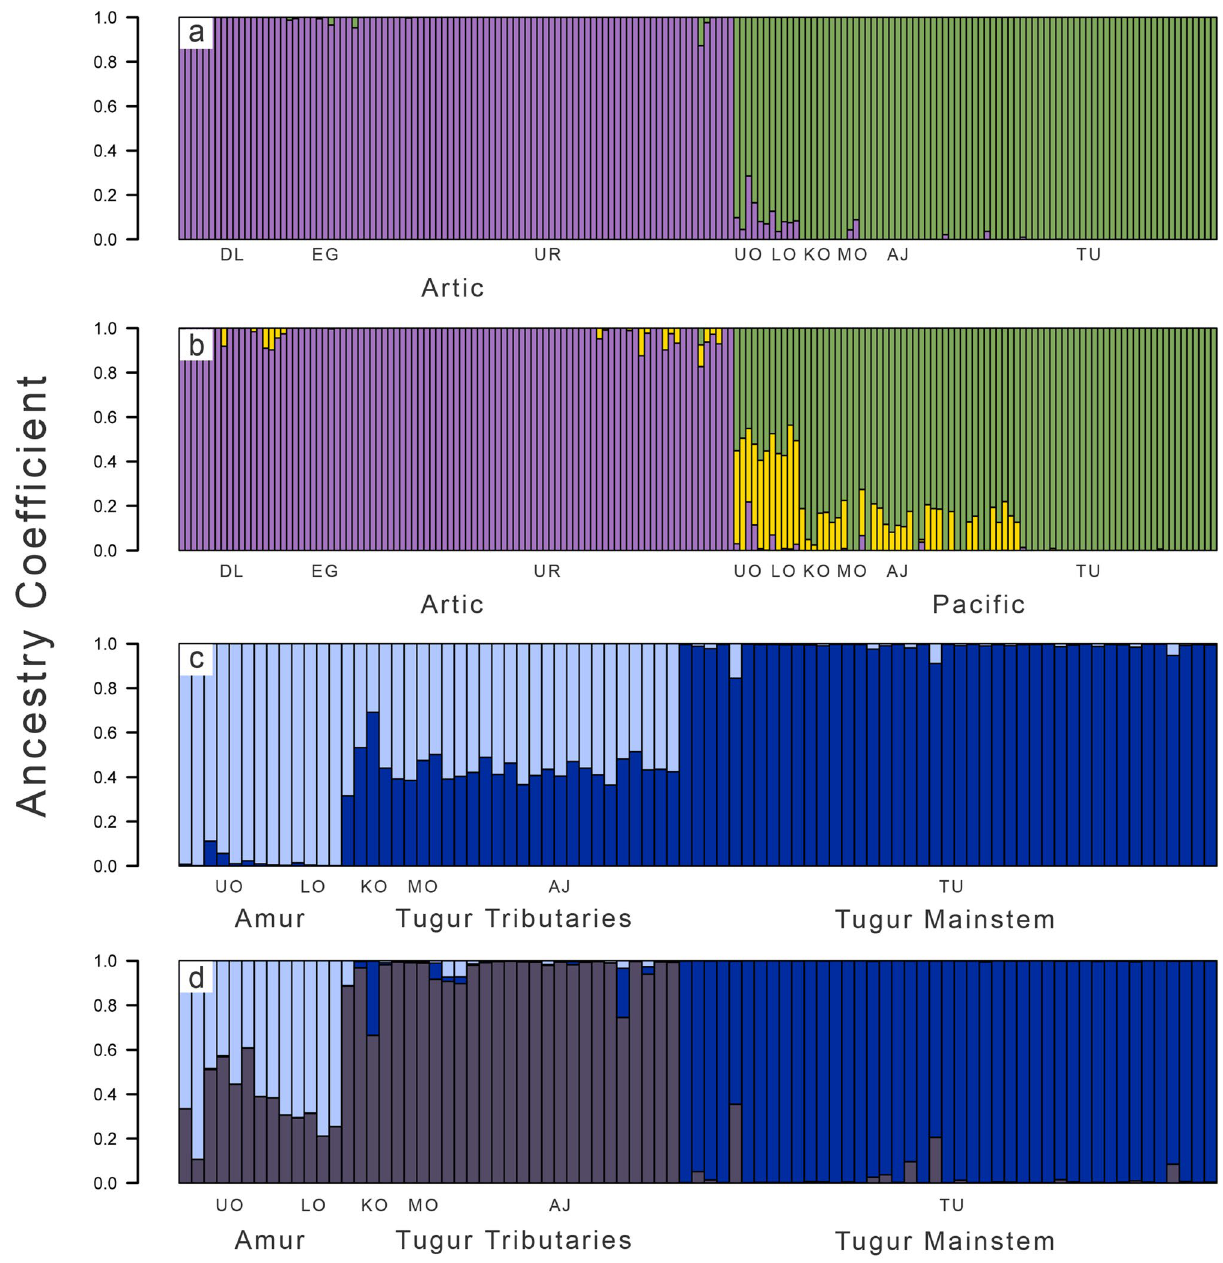
Figure 2. Ancestry coefficient estimates ( q ) generated with entropy for analyses based on all sampled individuals ( a , b ) and for separate analyses based on the subset of individuals from the two Pacific drainages ( c , d ). Vertical bars represent individuals, and colors correspond to the admixture proportions for each of k clusters. For both sets of analyses, the k = 2 models ( a , c ) fit the data best. Models for k = 3 ( b , d ) are additionally shown for each set of analyses as the revealed patterns of clustering further illustrate population genetic structure within river systems. As in Fig. 1, sampling sites correspond to those in Table 1 and include the Delgermörön (DL), Eg (EG), Uur (UR), Lower Onon (LO), Upper Onon (UO), Tugur (TU), Konin/Assyni Junction (AJ), Konin (KO), and Munikan (MO) sampling sites. Plotting was completed using R tree based on pairwise estimates of Nei’s D among sampling localities provided and alternative visualization of hierarchical genetic structure consistent with all other population genetic analyses (Fig. 3d). Genetic diversity varied across the sampled geographic regions. Mean genetic diversity across all nine sam- pling sites was 0.00164 for θ π (range 0.00119–0.00209) and 0.00132 for θ W (range 0.00077–0.00178). Genetic diversity was consistently higher in Pacific drainages (mean θ π = 0.00181, range 0.00165–0.00209; mean θ W = 0.00152, range 0.00119–0.00178) than in the Arctic drainage (mean θ π = 0.00130, range = 0.00119–0.00138; mean θ W = 0.00093, range = 0.00077–0.00101), as was H E (Arctic mean = 0.1195, range = 0.118–0.121; Pacific